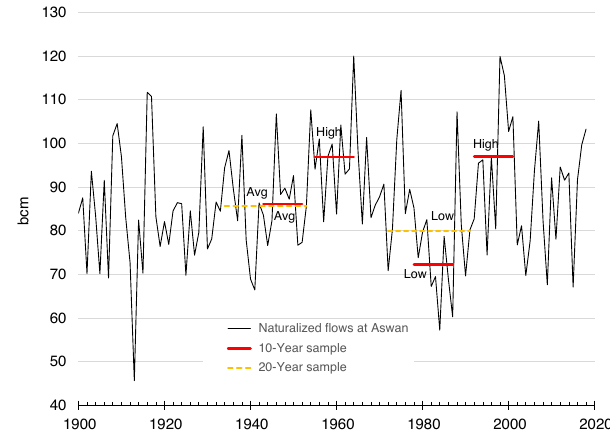
Fig. 2 Naturalized historical total annual fl ows at Aswan. Horizontal bars show 10- and 20-year sequences used in